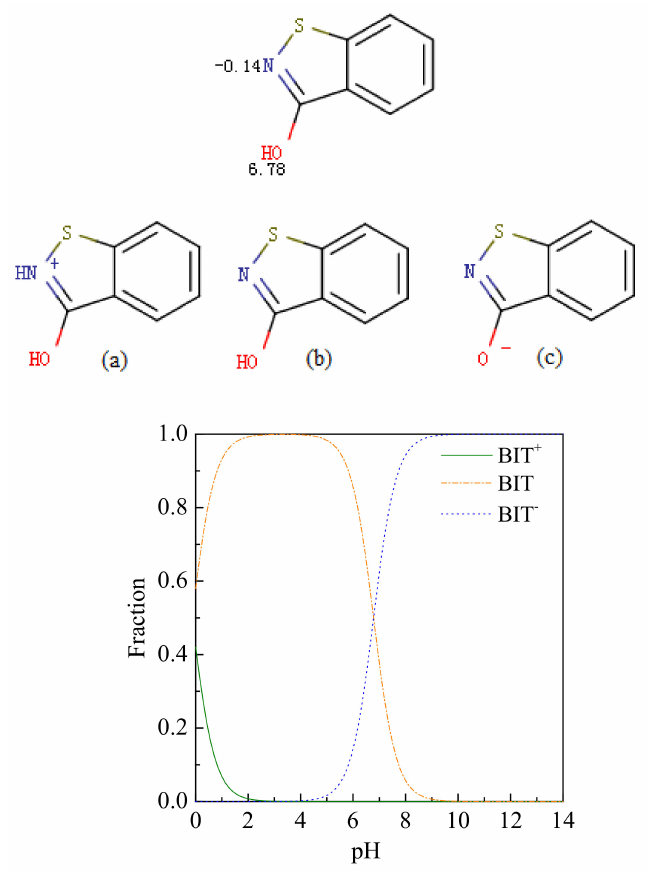
Figure 5. Influence of pH on the fraction of charging states of